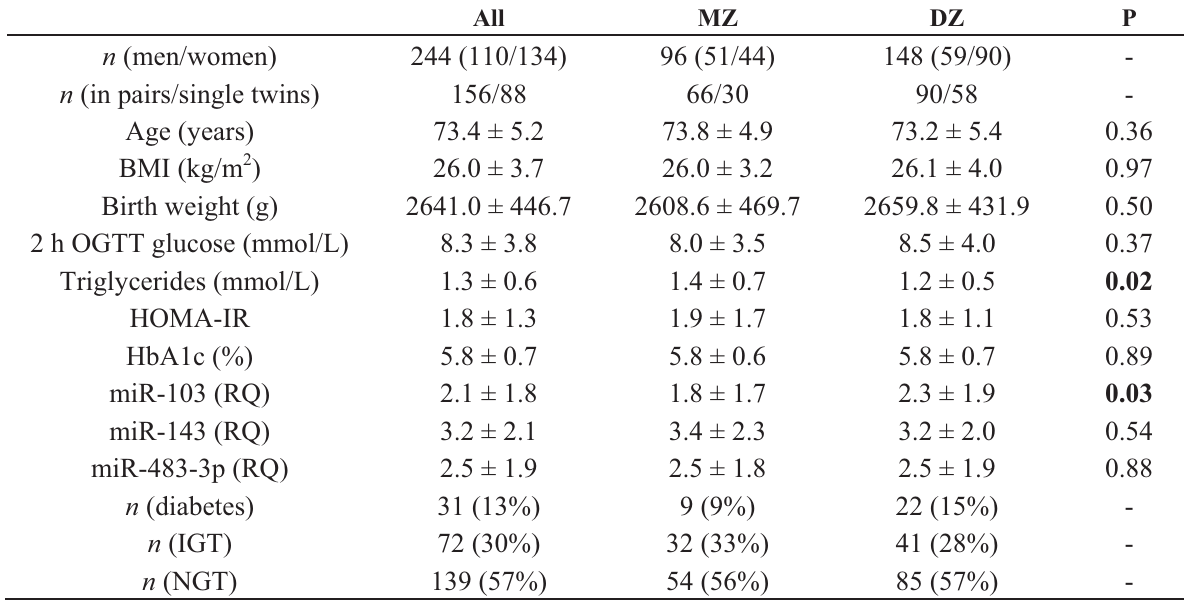
Table 1. Subject